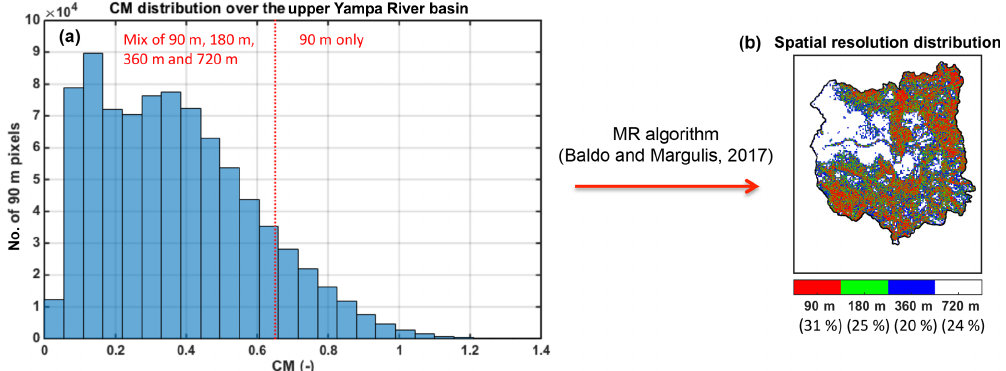
Figure 2. (a) Complexity metric distribution for the upper Yampa River basin. The choice of the maximum threshold CM max of 0.65 represented as the red vertical line leads to (b) the spatial resolution distribution